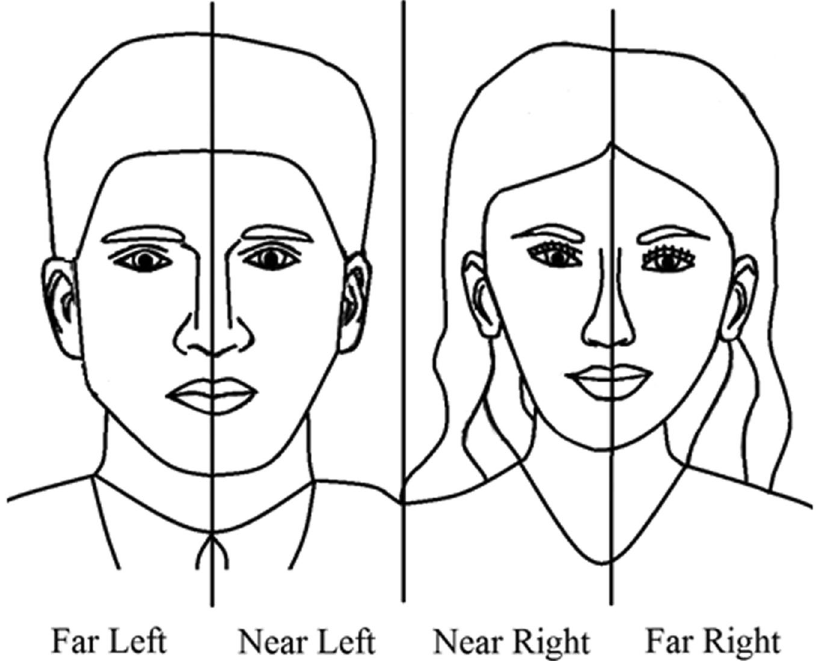
Figure 2. Regions of interest on one of the stimuli used in the Tracing and Copying Conditions. The stimulus was divided into equal quadrants that provided four regions of interest along the horizontal plane (Far Left, Near Left, Near Right and Far Right) for the behavioral (figure completion accuracy) and eye movement measures